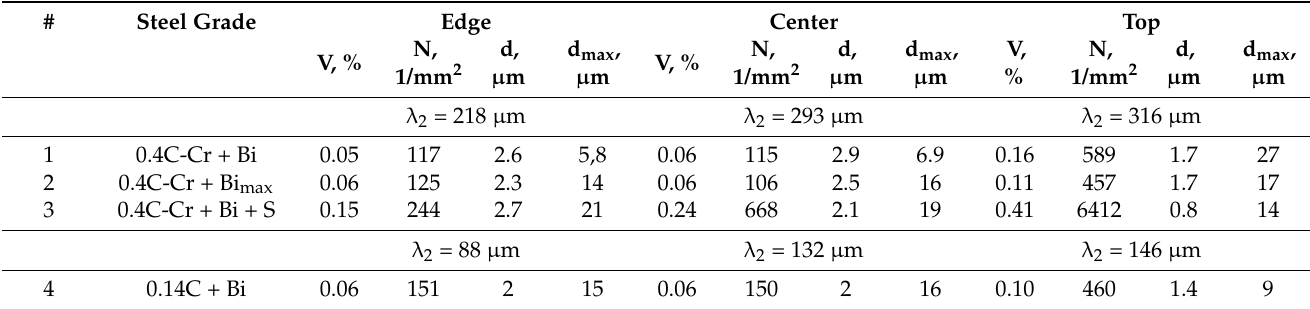
Table 4. Results of evaluation of the parameters of the cast structure and inclusions in experimen- tal